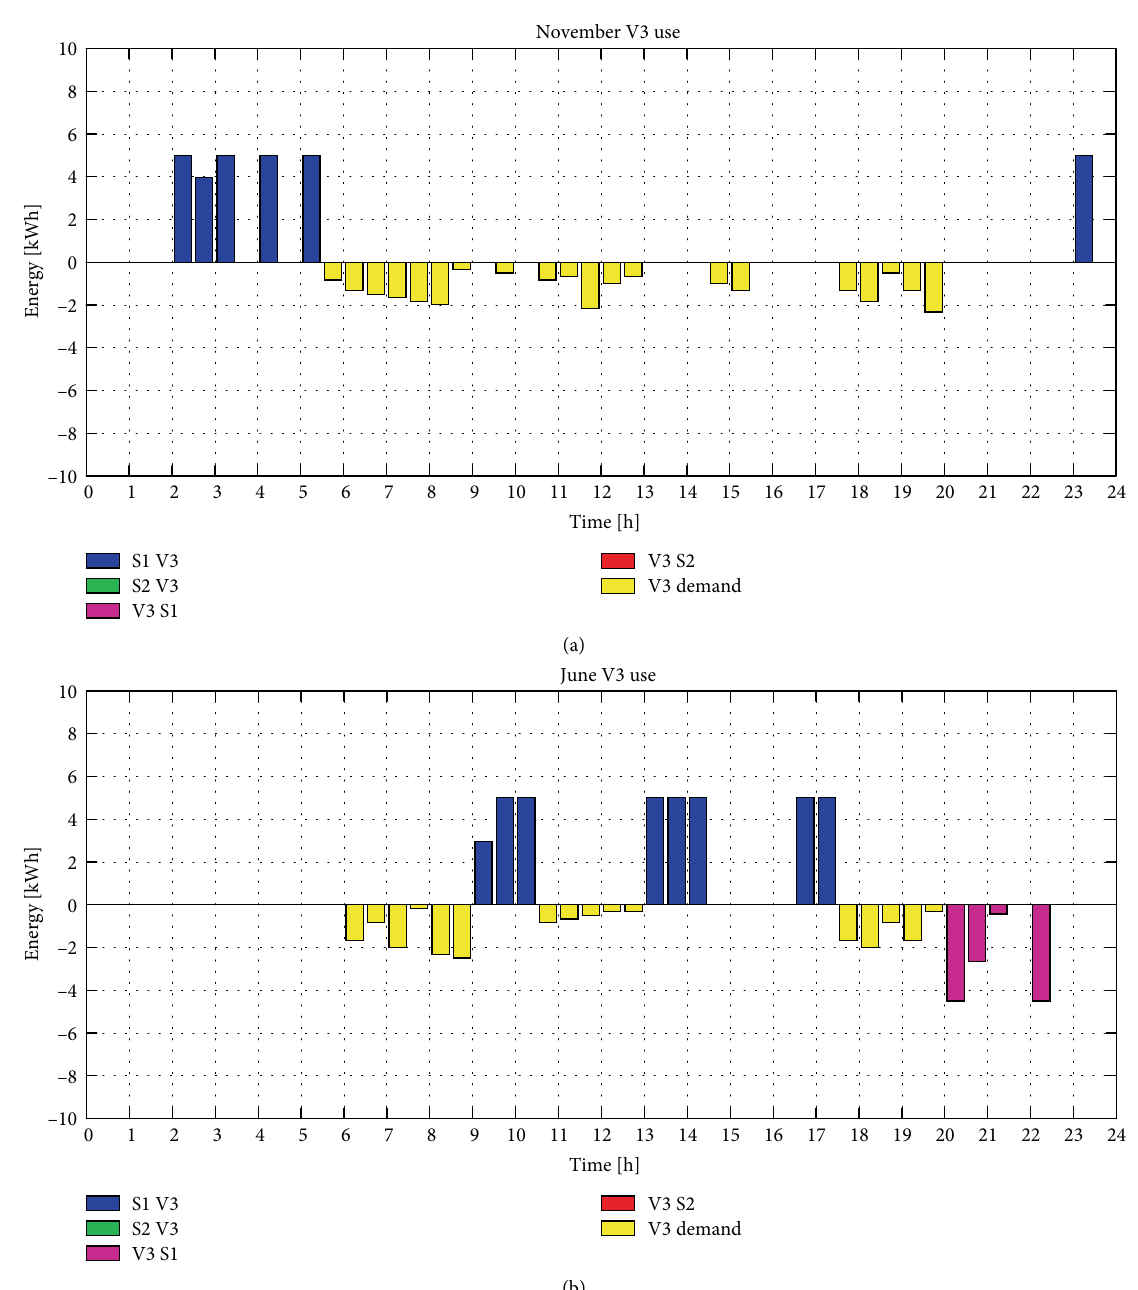
Figure 6: (a) November day electrical profiles for one “Nissan Leaf” in Case 4.1. (b) June day electrical profiles for one “Nissan Leaf” in Case